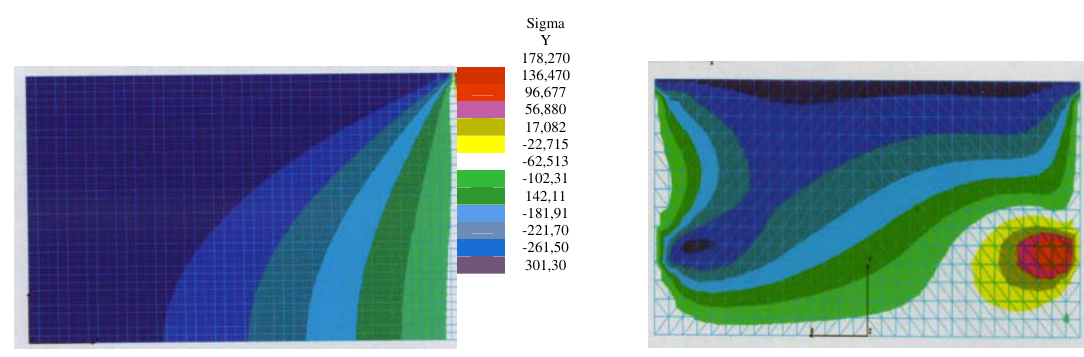
Fig 7 . Vertical soil displacements y u distribution during shear box test using stiff stamp (linear model)